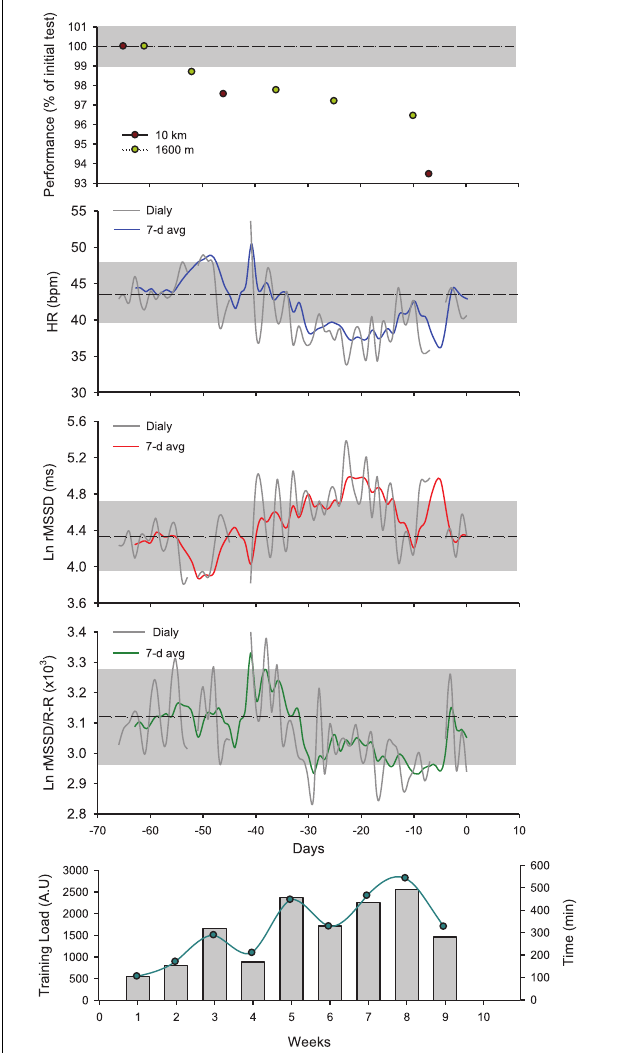
FIGURE 5 | Changesinrunningperformance(besttimeoveraself-paced 5 × 1600-m interval training session and an all-out 10-km run), resting heartrate(HR),logarithmofthesquarerootofthemeanofthesumofthe squares of differences between adjacent normal R-R intervals measured at rest after awakening (Ln rMSSD), the Ln rMSSD to mean R-R interval (Ln rMSSD/R-R) and training load (perceived exertion, CR-10 Borg scale × training duration Impellizzeri et al., 2004) and volume in a distance runner (32 year-old, VO 2max = 59ml/min/kg, vVO 2max = 18km/h) over the 9-week training program leading to his first marathon (3h 15min). The shaded areas represent trivial changes (see Table 2 ). Ln rMSSD and running performance change as a function of the training progression. While running performance improves continuously throughout, Ln rMSSD changes follow a bell-shaped relationship, with an initial increase followed by 2 consecutive reductions during the last phase of training. Interesting, while the decrease in Ln rMSSD during week 7–8 is concomitant with a plateau of theLnrMSSD/R-Rratio,thedecreaseobservedduringweek9occurswithan increase of the Ln rMSSD/R-R ratio. This suggests that the decrease during week 7–8 is likely related to a saturation phenomenon (further increase in vagal activity), while that seen at week 9 is more likely related to a decreased vagalactivity/increasedsympatheticactivity(whichmightbeneededtoreach greater exercise intensity during competition). This interpretation has important implications when using HRV to guide the training process, and is only possible when using the combination of both